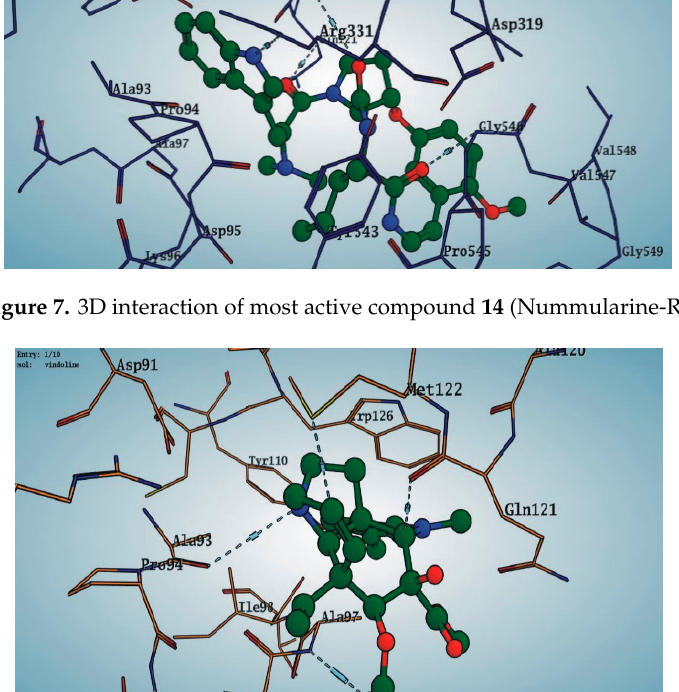
Figure 8. Interaction of compound 10 (Vindoline) with Ligand target protein. Ala93, Ala97, Gln121, and Trp126 form three Hydrogen and one arene-arene interaction with the ligand.